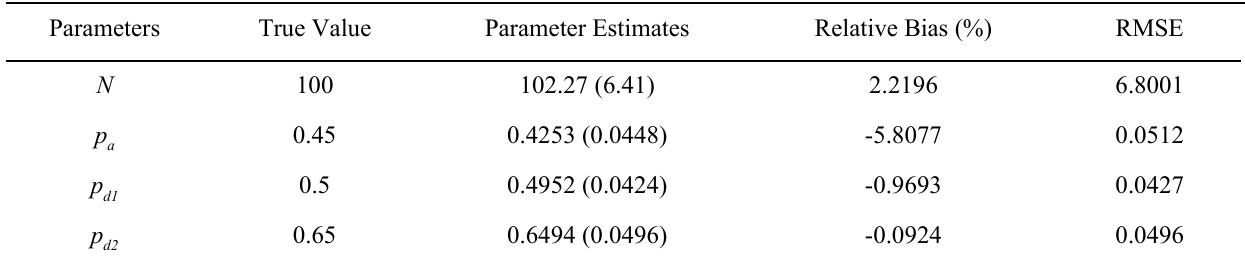
Table 3. A comparison of the simulated dataset parameter estimates (standard errors) for a random singing model – constant random temporary emigration model, with observer dependent detection probabilities constant over time intervals. The population of birds that sing at least once in eight minutes is N = 100. Estimates and standard errors found with B = 500 bootstrap